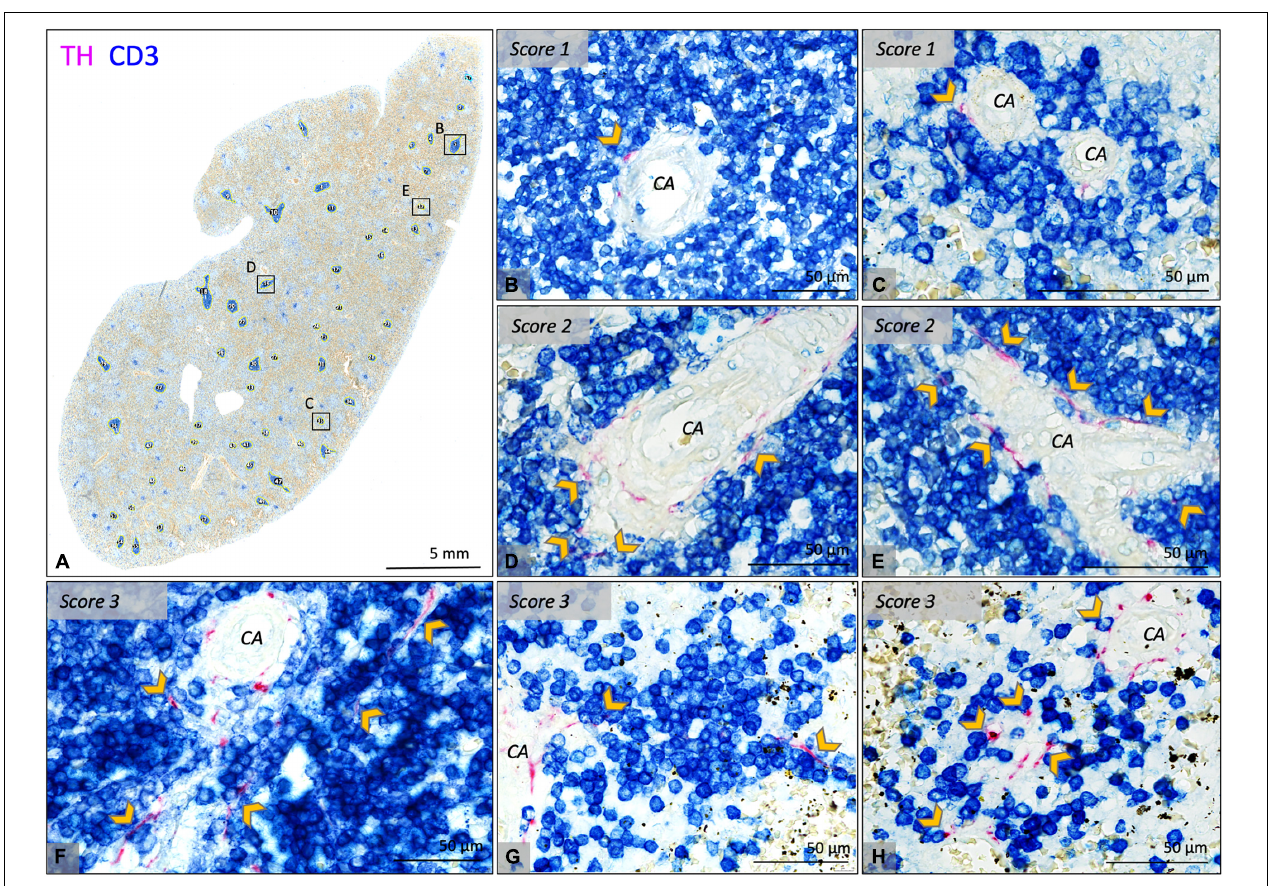
FIGURE 3 | Bright field microscopic images of PALS related sympathetic nerves in CD3/TH double stained splenic tissue slides of various neonatal individuals. (A) Overview image of a splenic sample showing automatically selected T cell regions which were further investigated for the presence of sympathetic nerves and their relation with T cells. (B–E) Close up images of the marked regions in (A) representing PALSs with a score 1 or 2. (F–H) Close up images of PALSs with a score 3 (all from different neonatal individuals). Score 1: Only one or two sympathetic nerves were observed to extend beyond the connective tissue of the vessel wall of the central artery (CA) and to be in close proximity with T cells immediately lining the vessel wall. Score2: multiple sympathetic nerves extended beyond the connective tissue of the CA and were in close proximity with T cells immediately lining the vessel wall. Score 3: comparable to 2, but nerves extended beyond T cells immediately lining the vessel wall. CA, central artery; Arrow heads: pointing out sympathetic nerves that are in close proximity with T cells, but might be obscured by the blue